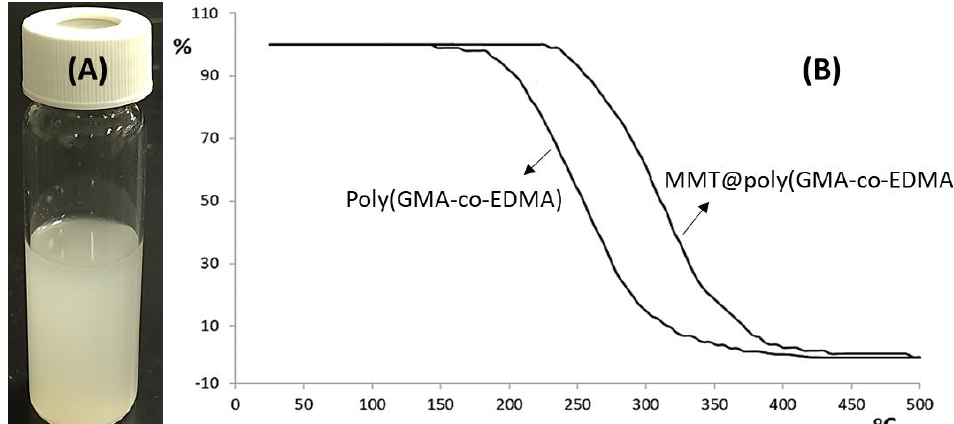
Figure 1. ( A ) Suspension of MMT in the porogenic solvents. ( B ) Thermal behavior of the poly(GMA- co-EDMA) monolithic polymer before and after the incorporation of MMT (3.0 mg mL −1 MMT). The samples were heated from 25 to 500 °C at a heating rate of 10 °C min – 1 .